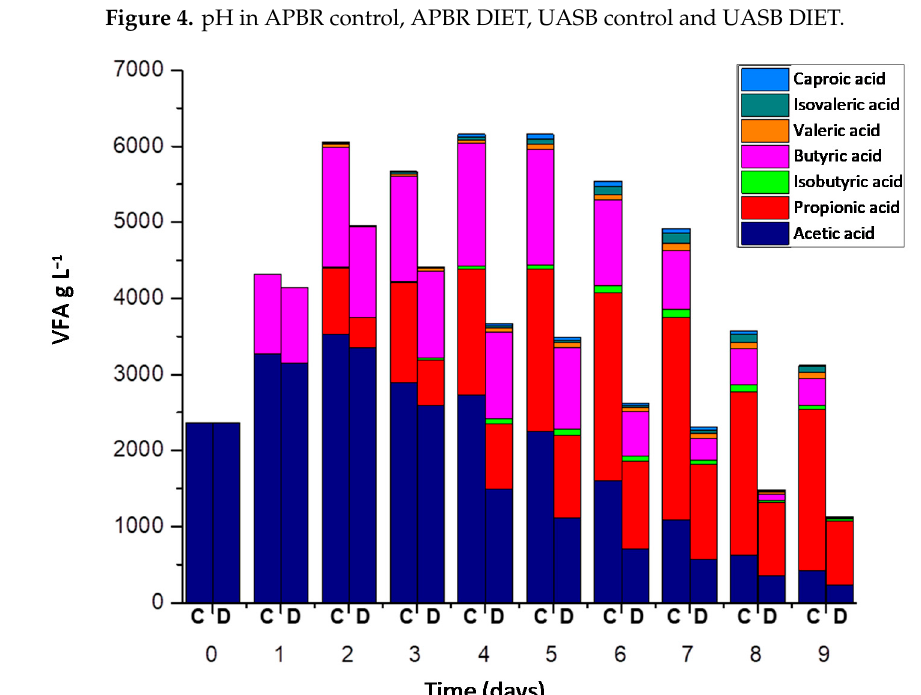
Figure 5. VFA concentration in Control process = C (APBR control + UASB control) and DIET process = D (APBR DIET + UASB DIET).